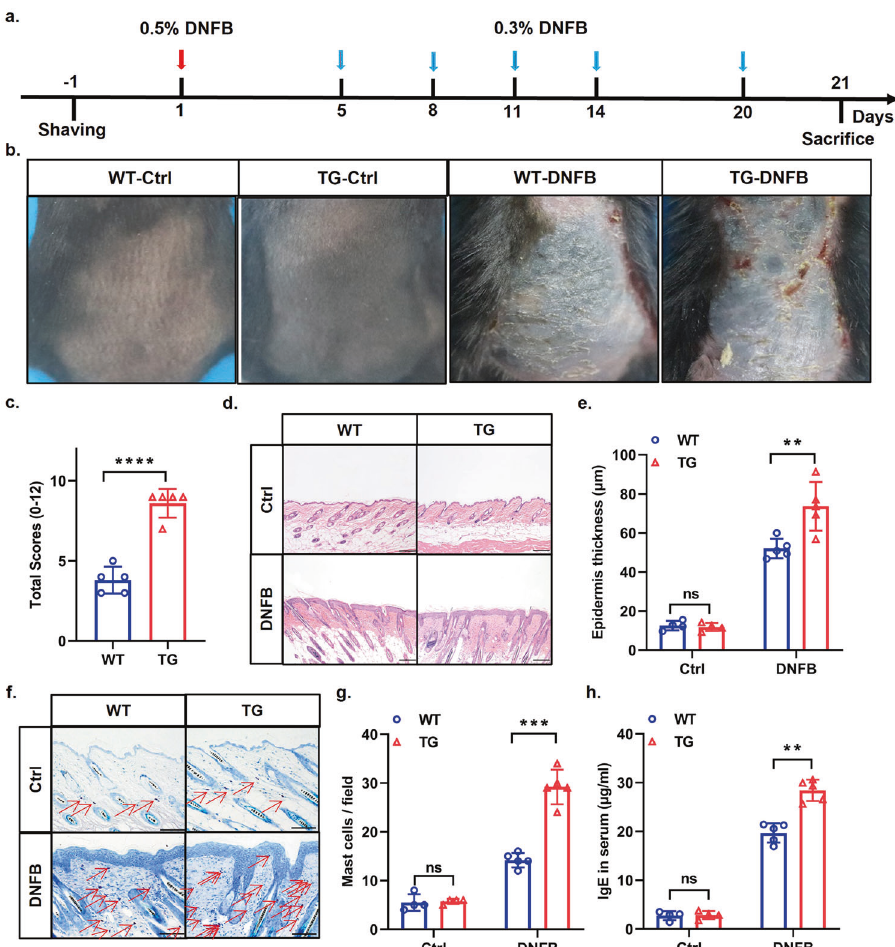
Fig. 3 WFDC12-overexpressing exacerbated DNFB-induced AD-like symptoms in mice. a Established scheme of DNFB-induced AD mouse model. b Dorsal skin lesions after 21 days of modeling. c Total scores of dorsal skin lesions after 21 days of modeling ( n = 5). d The H&E staining representative fi gure in skin lesions. Scale bar. 200 μ m. e Quantitative analysis of epidermal thickness. Five visual fi eld measurements were randomly selected for each sample ( n = 4). f Toluidine blue staining representative images. scale bar 100 μ m; Arrows indicate mast cells. g Statistical results of mast cells. Five visual fi eld measurements were randomly selected for each sample ( n = 4 or 5). h ELISA was used to detect serum IgE ( n = 4 or 5). Data were expressed as mean ± SD. Asterisks indicate statistical signi fi cance based on unpaired or paired T -test; * p < 0.05, ** p < 0.01, *** p < 0.001, **** p < 0.001, ‘ ns ’ indicates no statistical